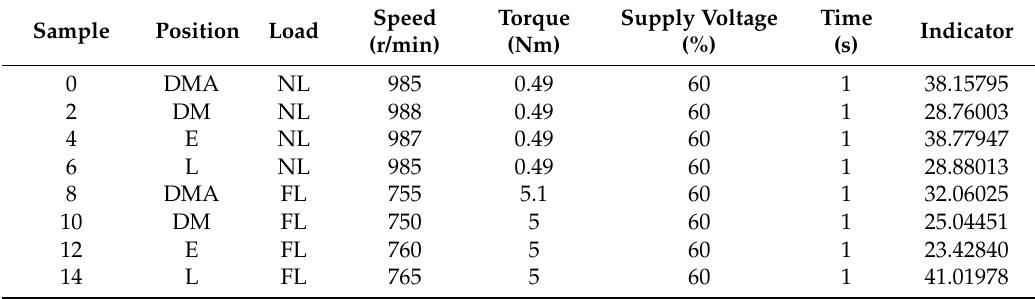
Table 7. Results of the indicator in the frequency domain based on Equations (4) and (5) for the data of the experiment with the faulty motor with a broken bar, during start-up.